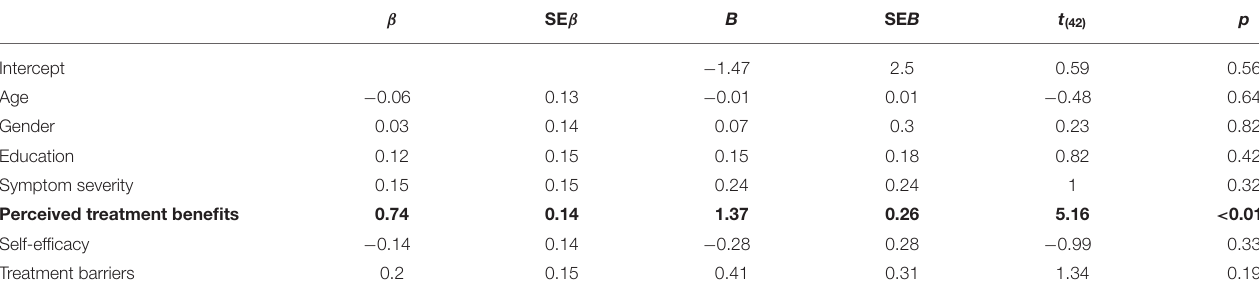
TABLE 2 | Regression results for the outcome variable: help-seeking intention*.